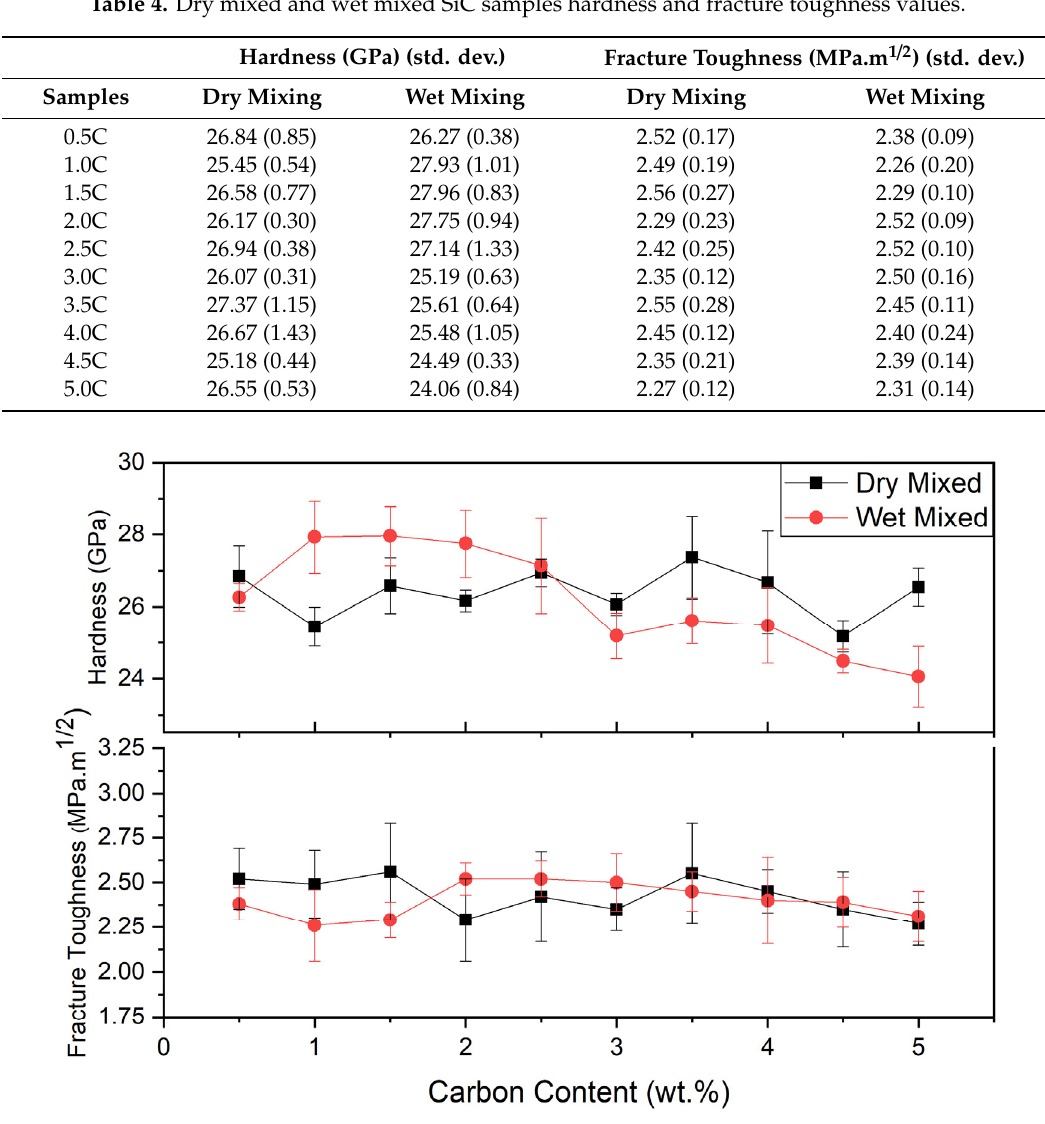
Figure 5. Dry mixed and wet mixed SiC samples hardness and fracture toughness. Fracture toughness values vary in between 2.26 and 2.52 MPa.m 1